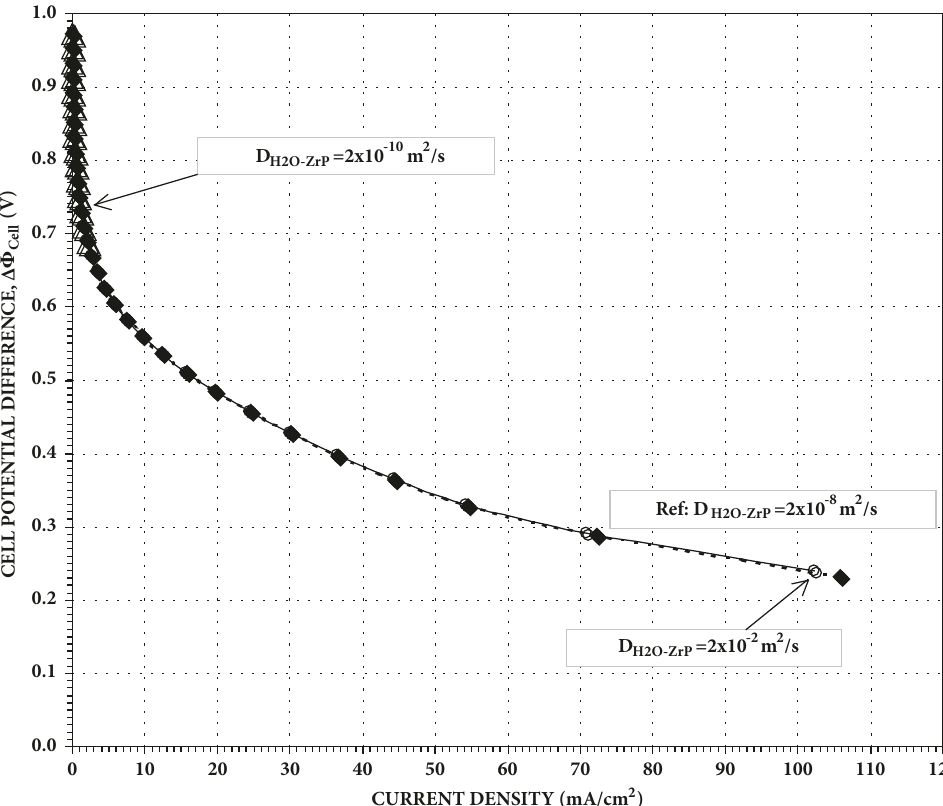
Figure 9: The effect of the water diffusivity coefficient in the electrolyte phase, D (m 2 /s), on the polarization curve for a direct propane H2O-ZrP (m 2 /s) for the above three cases were represented by the following symbols: fuel cell (DPFC) model at 150 ∘ C and 1 atm. The values of D H2O-ZrP (i) open triangles: 2x10 −10 m 2 /s, (ii) solid diamonds: 2x10 −8 m 2 /s (reference case), and (iii) open circles: 2x10 −2 m 2 /s. All the other parameters were the same as the reference case mentioned in Table